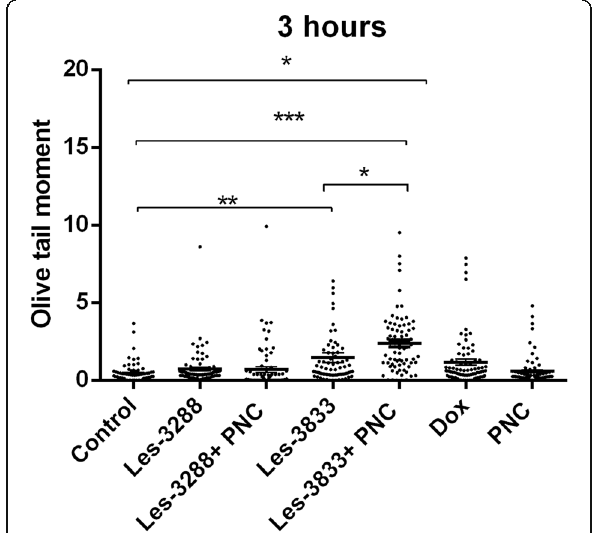
Fig. 9 DNA damage was evaluated using the Olive tail moment in rat glioma C6 cells treated for 3 h with experimental antineoplastic compounds used at a 0.5 μ g/mL concentration. * P ≤ 0.05; ** P ≤